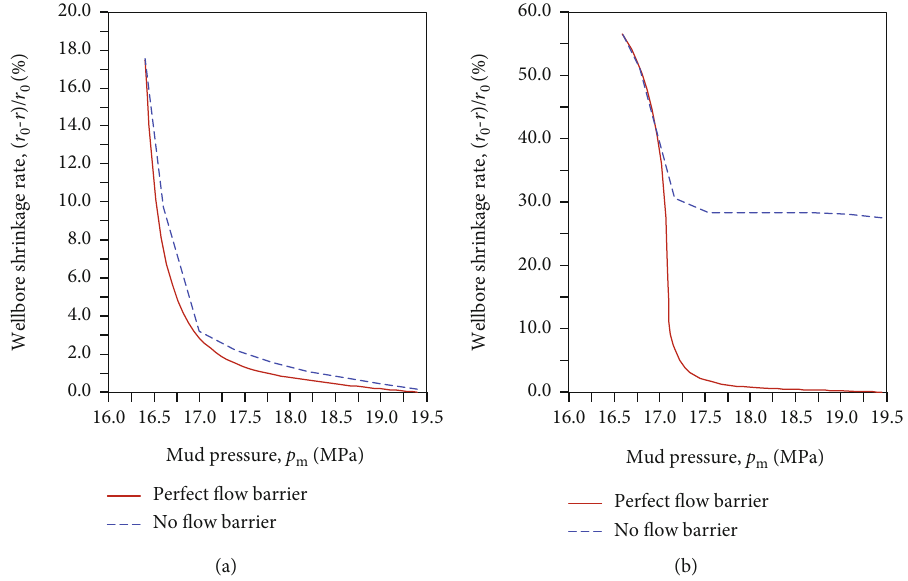
− r Þ / r 0 0 varying with mud pressure